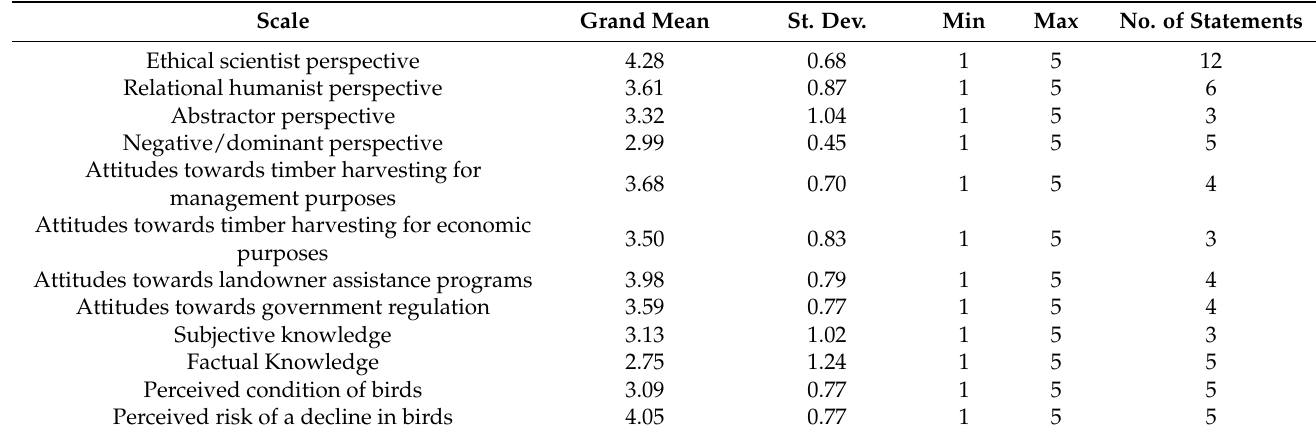
Table 5. Descriptive statistics for 5-point Likert scale agree/disagree questions measuring attitudes and knowledge parameters ( n = 656).